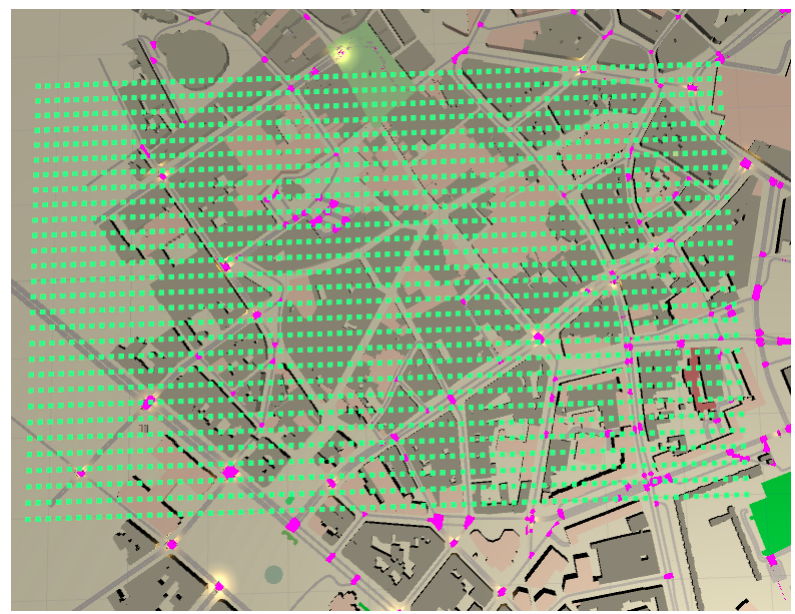
Figure 1. Three-dimensional environment model of Lille City 1 km 2 area with 2088 receiver grid represented in green